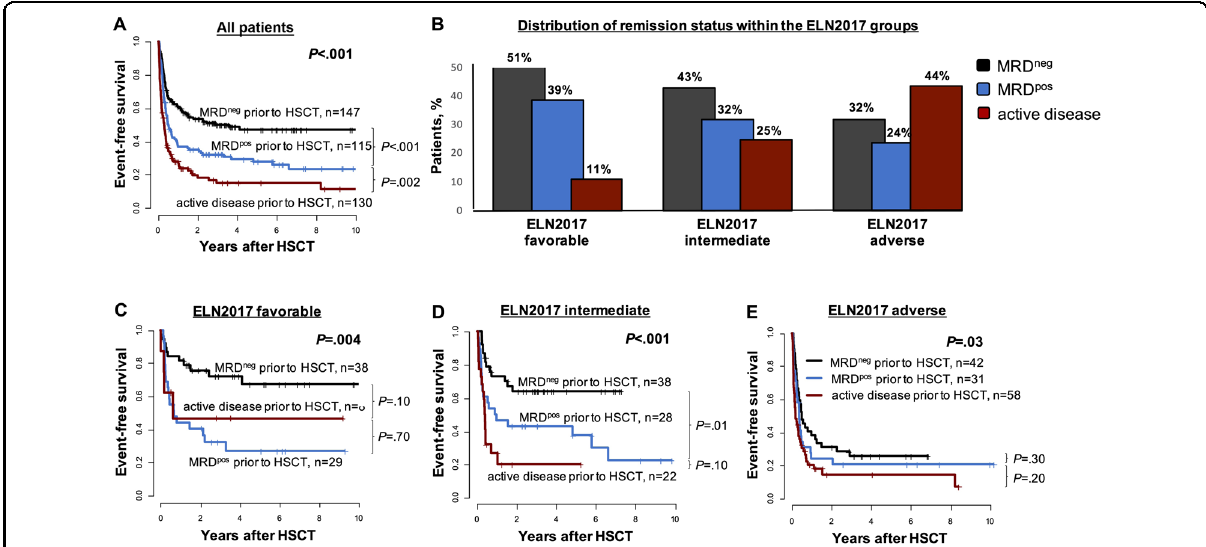
Fig. 1 Outcome and ELN2017 risk distribution according to remission status prior to allogeneic RIC- or NMA-HSCT (MRD neg vs MRD pos vs active disease, n = 392). A Event-free survival of the whole patient cohort, B distribution of the remission status prior to allogeneic RIC- or NMA- HSCT according to the ELN2017 risk strati fi cation system, C event-free survival in ELN2017 favorable-risk patients ( n = 75), D event-free survival in ELN2017 intermediate-risk patients ( n = 88), and E event-free survival in ELN2017 adverse risk patients ( n =